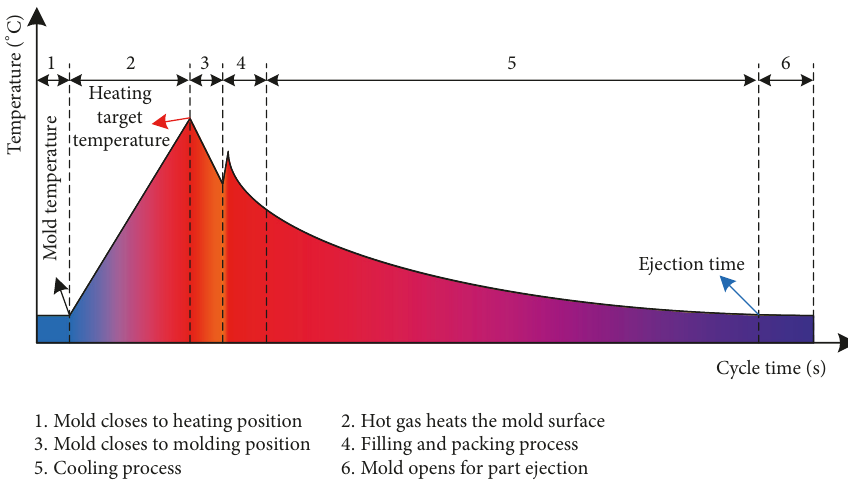
Figure 1: General process of gas-assisted mold surface heating in injection molding [17].